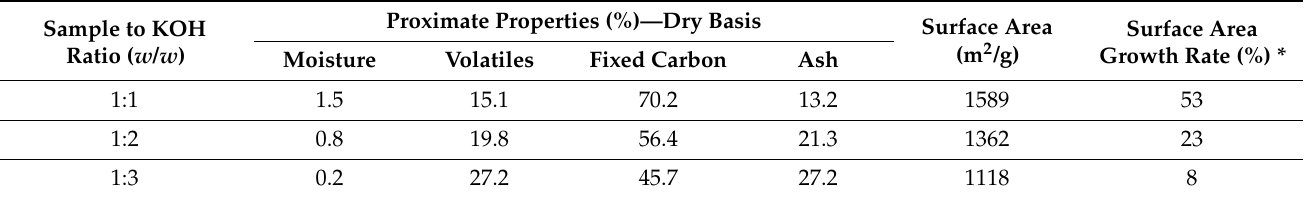
Table 6. The physical properties and surface area of